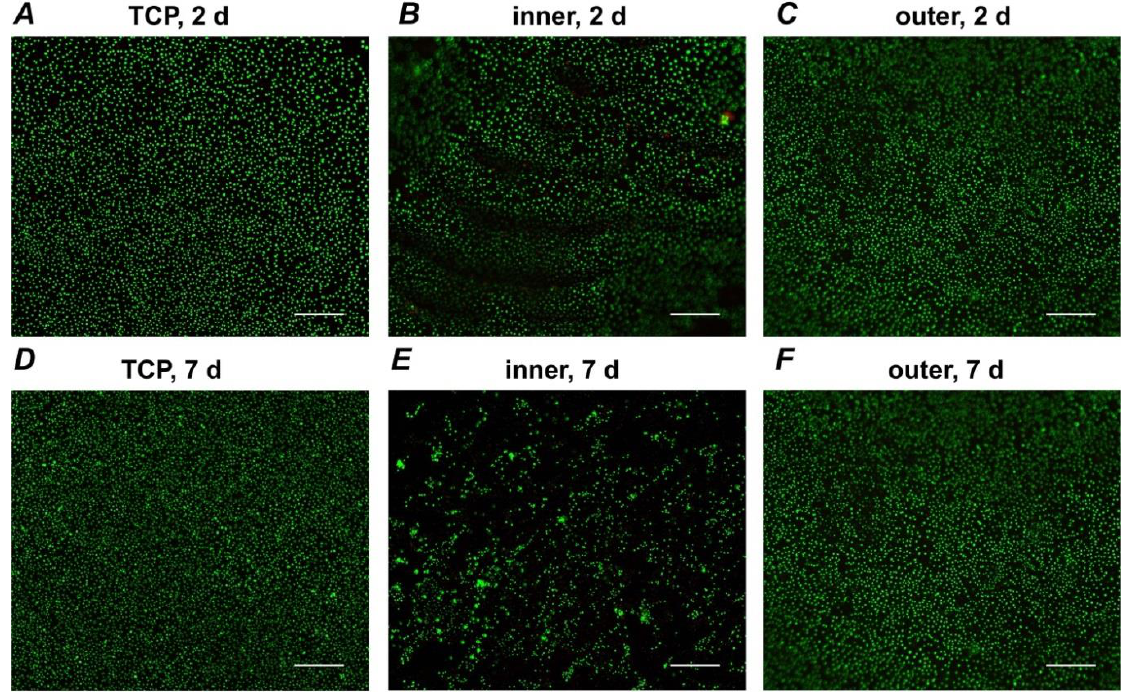
Figure 4. Live/dead Staining. HOKs were grown on TCP ( A , D ), inner ( B , E ), and outer ( C , F ) aligner surfaces for 2 and 7 days and were stained with Live/dead staining kit. Vital cells are visible as green, while the dead cells are presented red. Images are taken from a representative experiment. Scale bar corresponds to 200 µm.